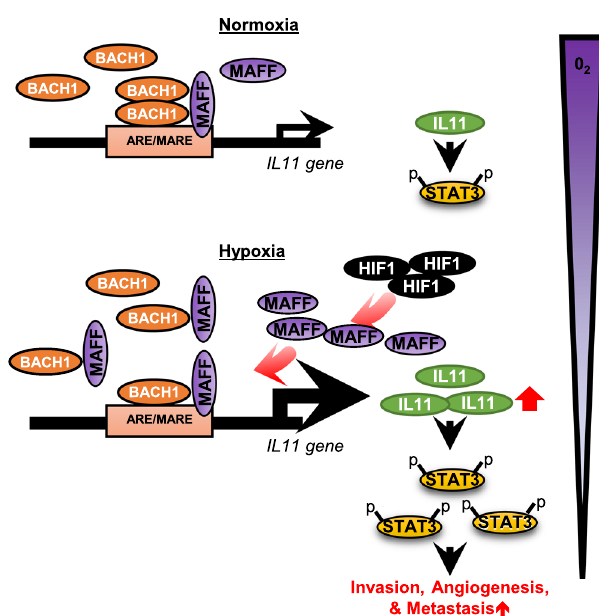
Fig. 9 Summary of hypoxia-induced MAFF and its role in tumor invasion and metastasis through IL11/STAT3 pathways. Hypoxia-induced MAFF binds to BACH1 to transcriptionally activate IL11. Increased IL11 leads to elevated phosphorylation of STAT3, which results in enhanced tumor invasion, angiogenesis, and